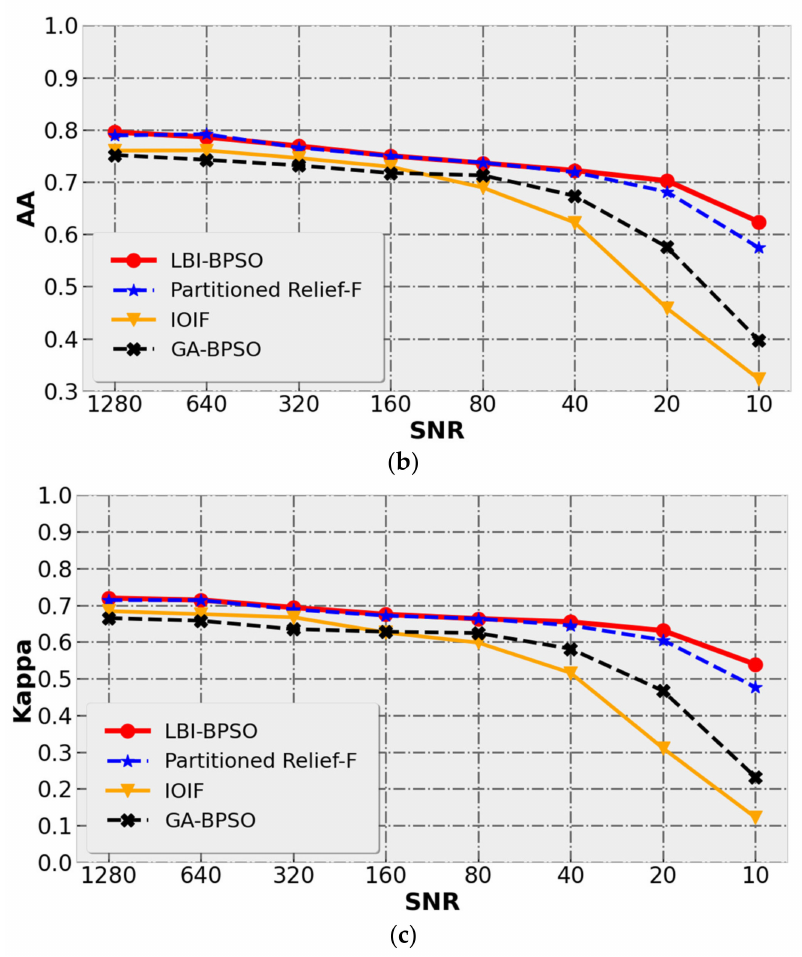
Figure 13. ( a ) Comparison of OA under different SNRs; ( b ) comparison of AA under different SNRs ( c ) Comparison of Kappa coefficients under different